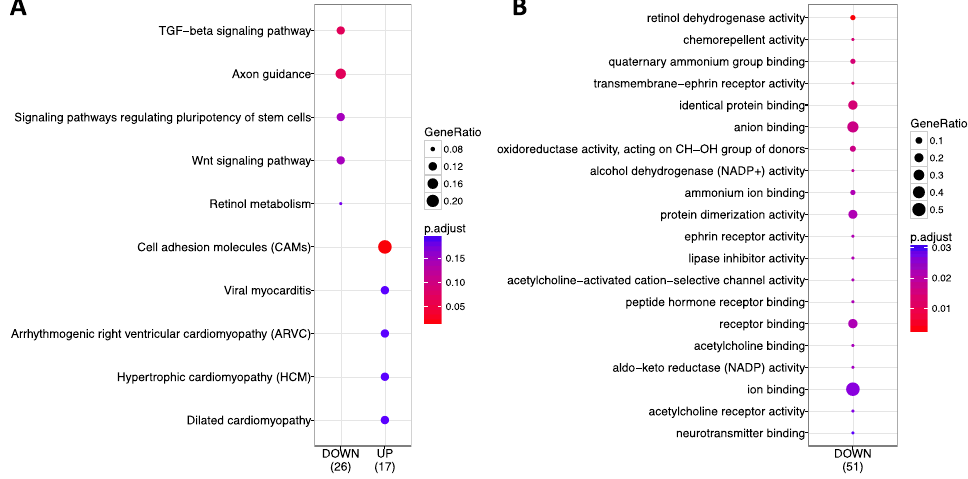
Figure 2. Comparative study between under-expressed and over-expressed genes using ClusterProfiler method. Comparative analysis based on KEGG ( A ). Comparative analysis based on Gene Ontology ( B ). GeneRatio corresponds to the number of genes from a specific category. Enrichment term is represented by coloured dots (red indicates high enrichment and blue indicates low